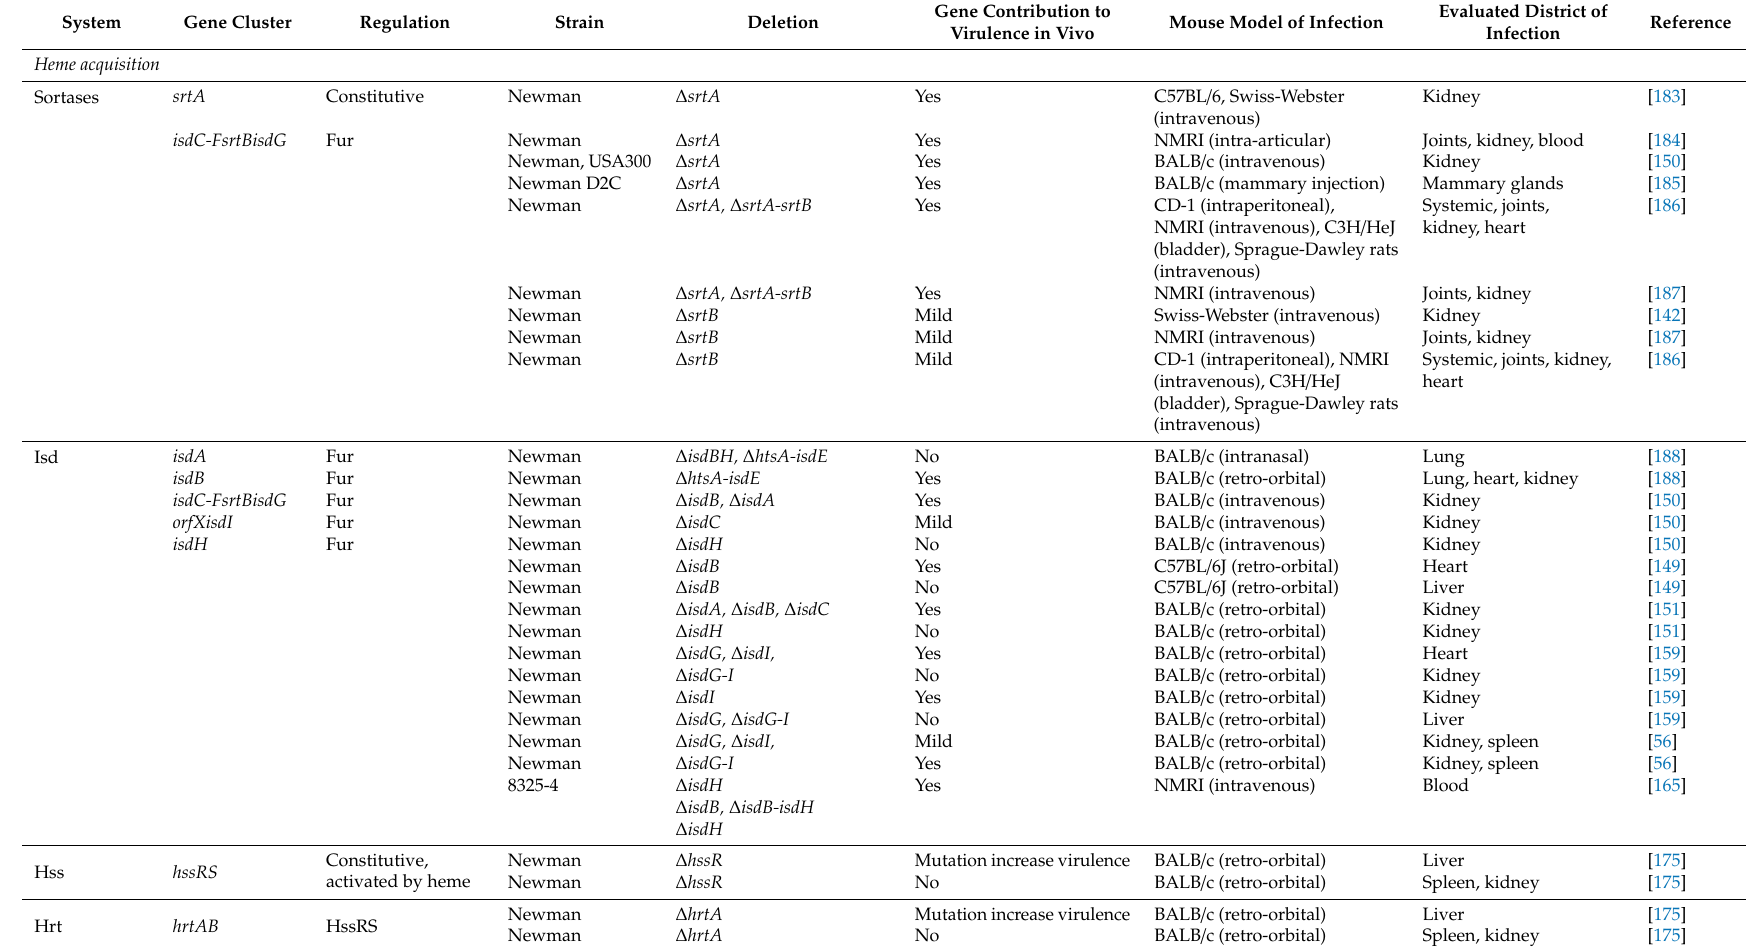
Table 2. S. aureus deletion mutants in animal models of